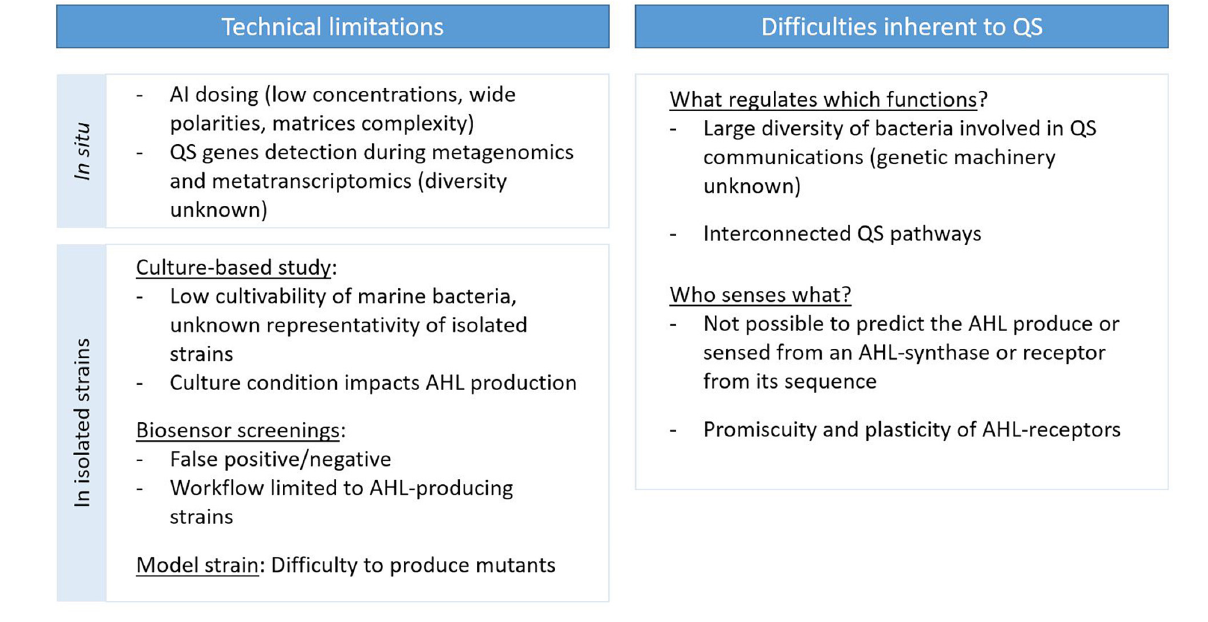
FIGURE 4 | Current limitations and difficulties restricting our ability to investigate QS